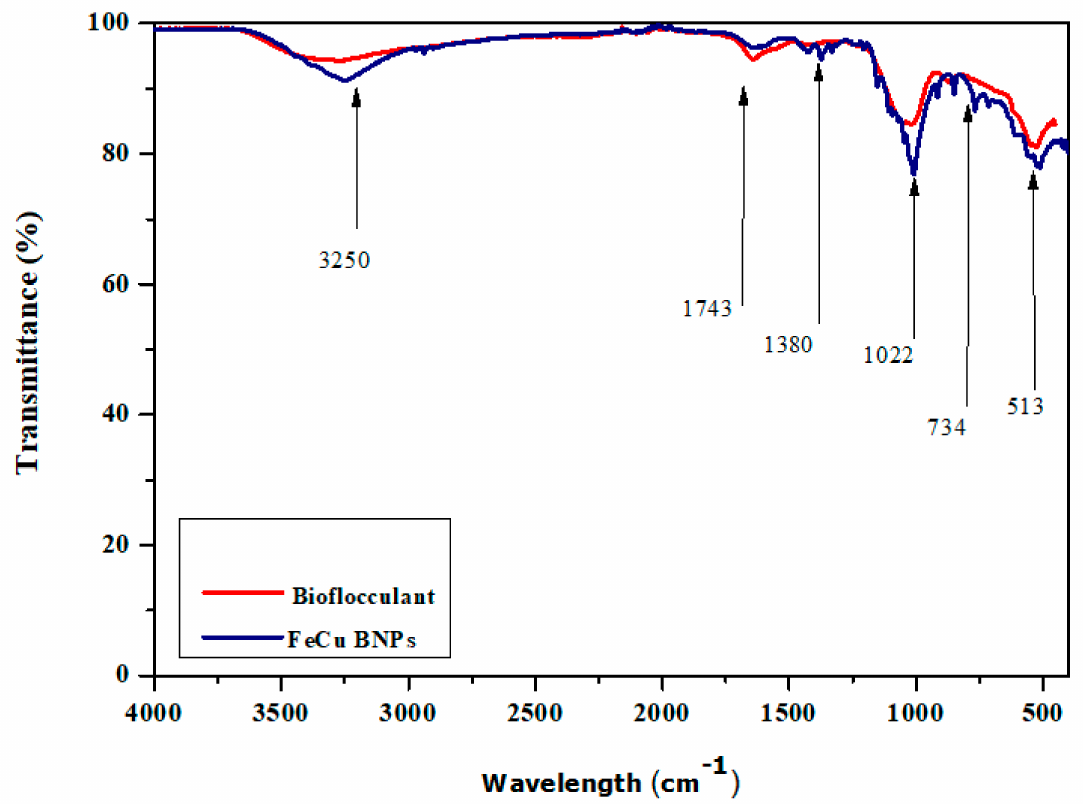
Figure 1. Fourier transform-infrared (FT-IR) spectrum of FeCu nanoparticles.